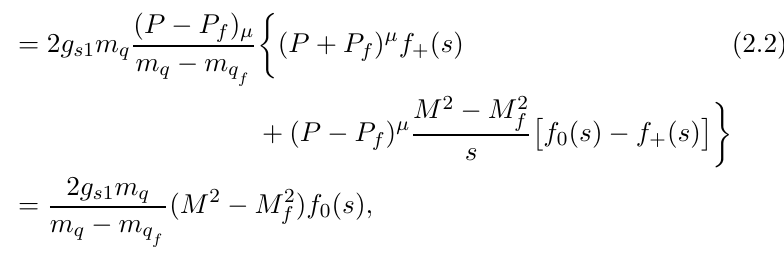
(cid:25) ( K ) processes !